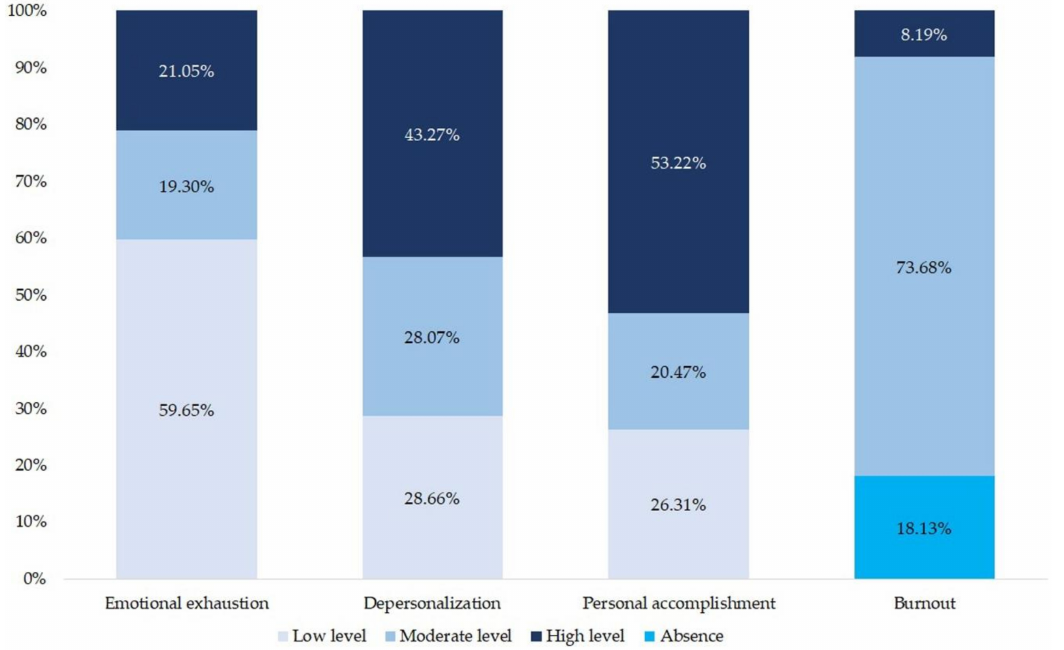
Figure 1. Levels of emotional exhaustion, depersonalization, personal accomplishment, and